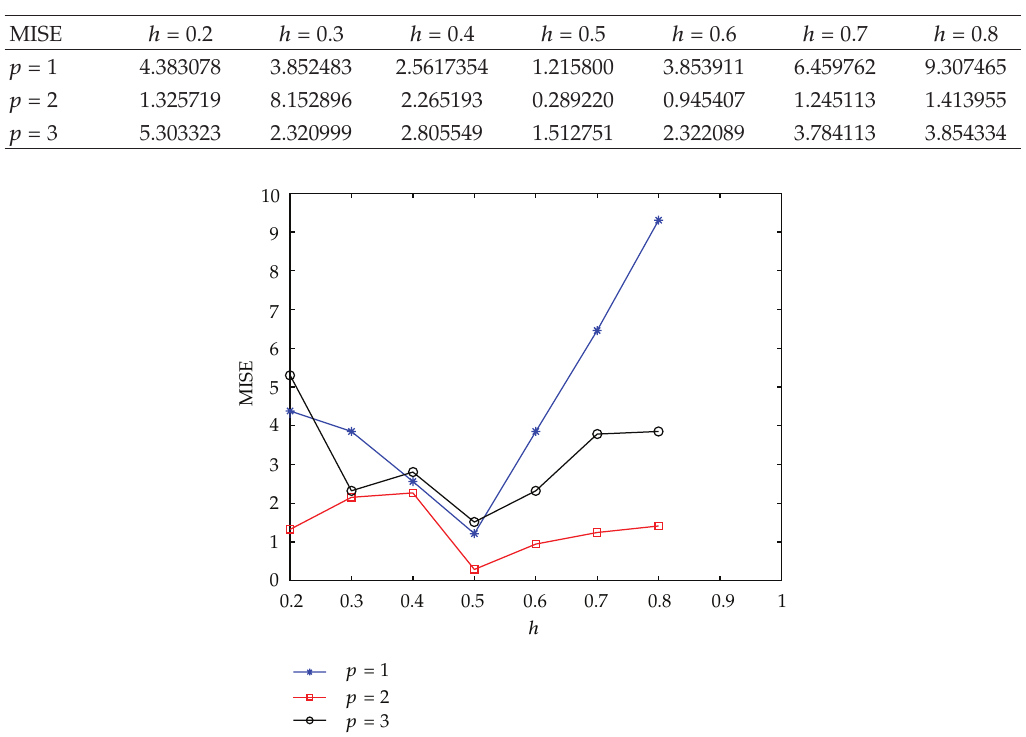
Table 1: Values of MISE under di ff erent orders and bandwidths.